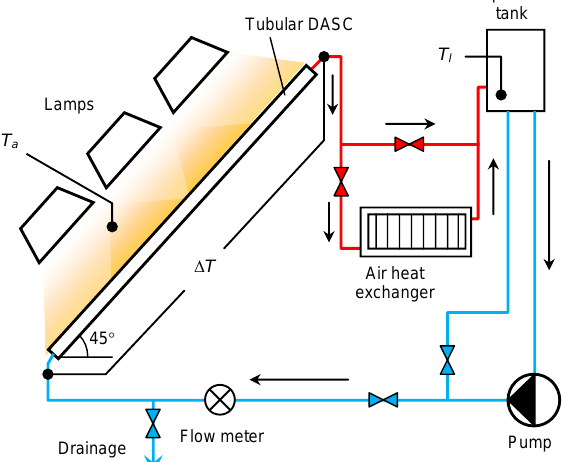
Figure 3. The experimental scheme.